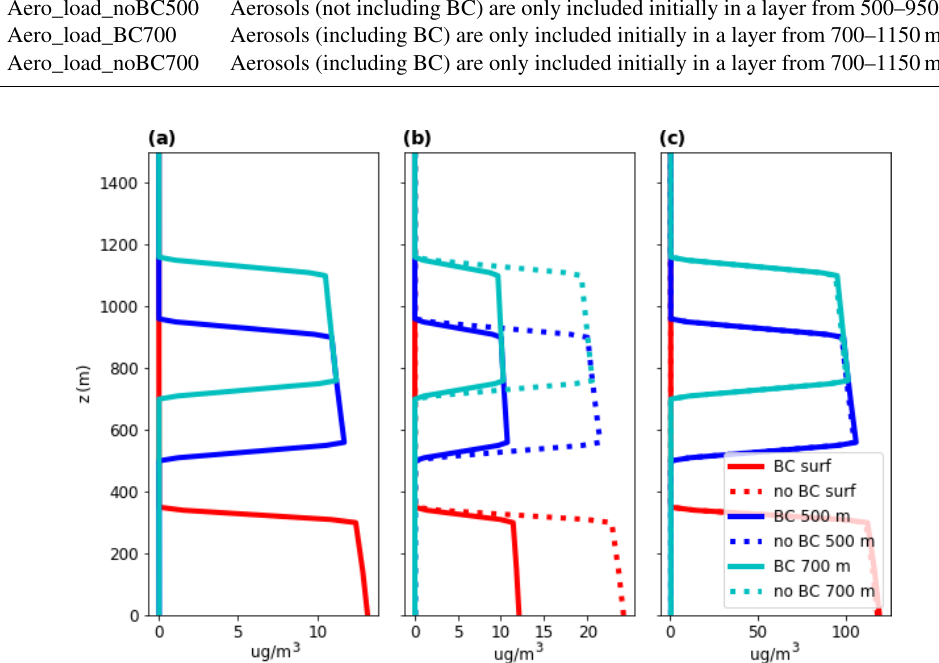
− and (c) total aerosol concentrations for simulations in case 1. Different heights Figure 2. Initial mass concentrations of (a) BC, (b) SO 2 4 were chosen for the initial aerosol layers, which were 0–350m (red lines), 500–950m (blue lines) and 700–1150m (cyan lines). Simulations which included BC are depicted by solid lines, and those without are dashed